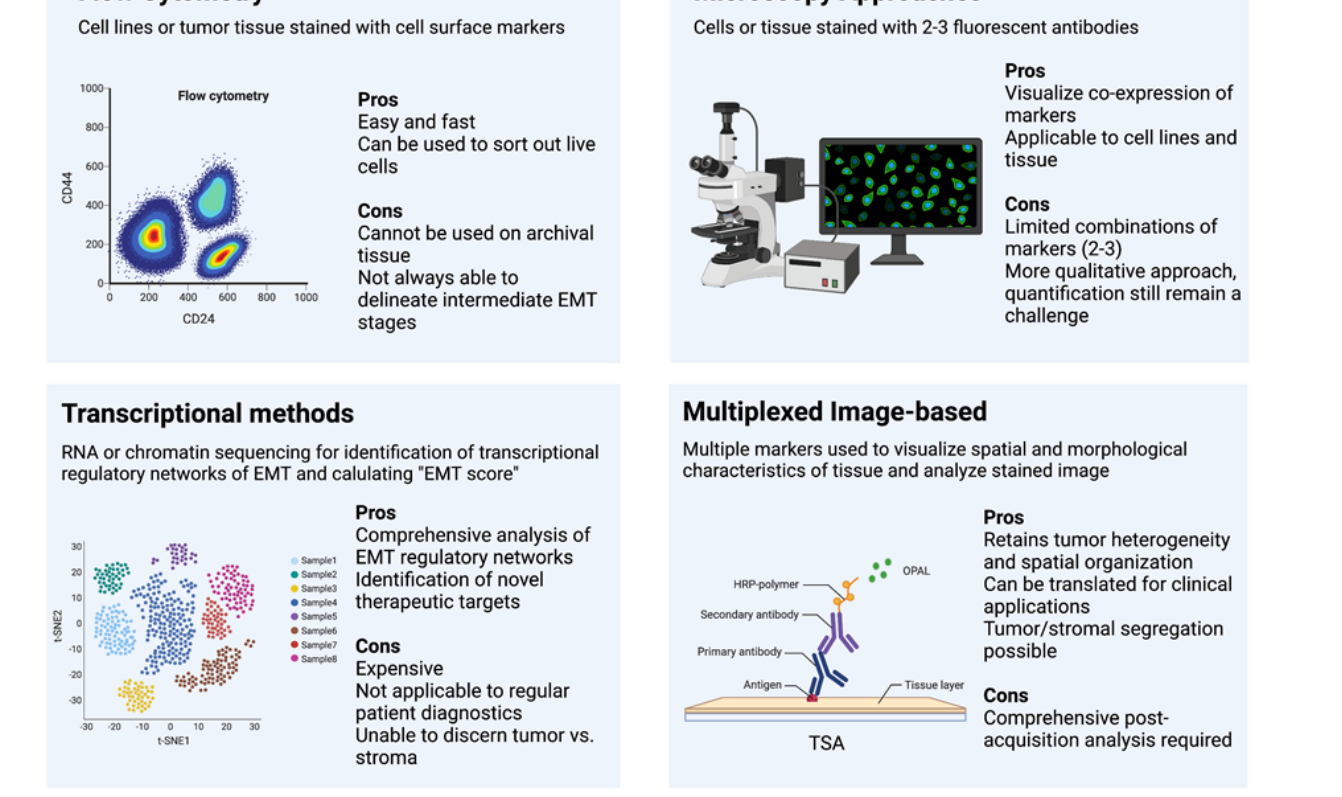
Figure 1. Methods of Assessing EMT.